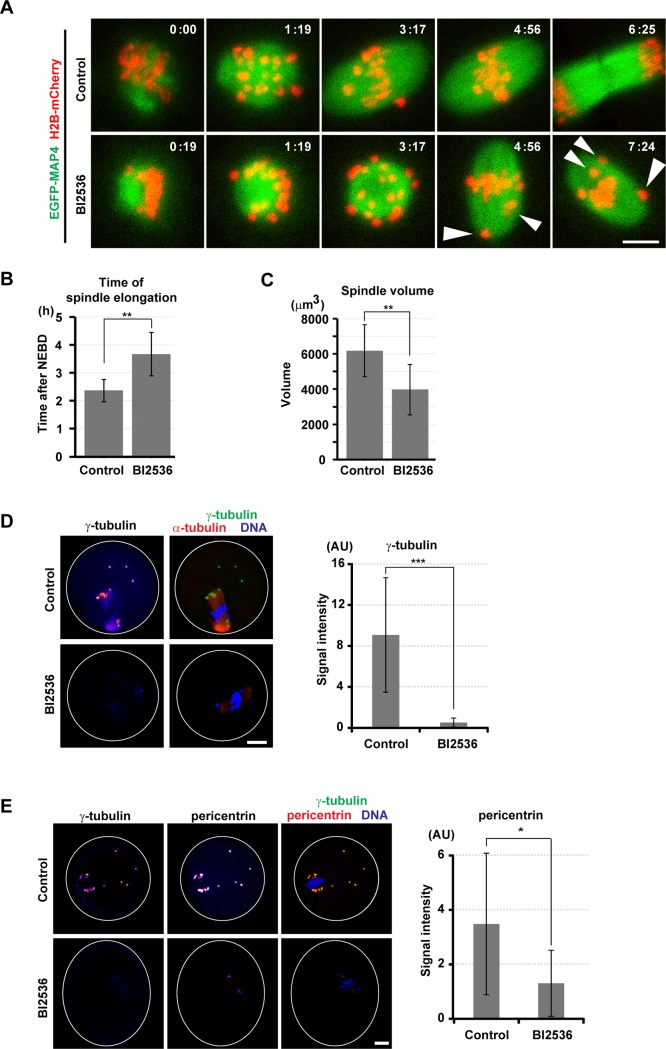
PLK1 is required for spindle formation with acentriolar MTOCs.(A) Imaging of meiosis I in oocytes expressing EGFP-MAP4 (microtubules, green) and H2B-mCherry (chromosomes, red) in the presence of DMSO (control) or 100 nM BI2536. Maximum intensity z-projection images are shown. Arrowheads indicate misaligned chromosomes. Time after NEBD (h:mm). Scale bar = 10 μm. Also see S3 Movie. (B) The EGFP-MAP4 signals were reconstructed in 3D (see S4A Fig.) and the time of spindle elongation was determined. Averages and s.d. are shown (n = 8, 17. **p < 0.01). (C) The volume of the spindle at 6 hours after NEBD was measured after 3D reconstruction of EGFP-MAP4 signals. Average and s.d (n = 8, 17. **p < 0.01). (D) Control and BI2536-treated oocytes at metaphase I were stained either for γ-tubulin (green) and acetylated α-tubulin (red) or (E) for γ-tubulin (green) and pericentrin (red). DNA was stained with DAPI (blue). Maximum z-projections of entire confocal stacks are shown. Scale bar = 10 μm. Quantifications of the spindle pole-associated integrated signals of γ-tubulin and pericentrin. Averages with the 95% confidence intervals are shown (n = 6, 7, 4, 4. ***p < 0.002, *p < 0.05).